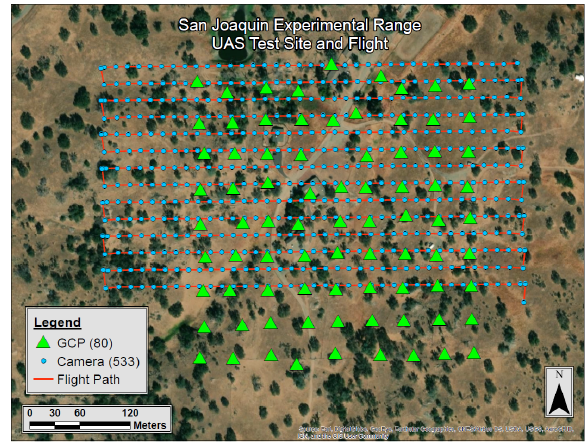
Fig. 3. Flight trajectory image for the project